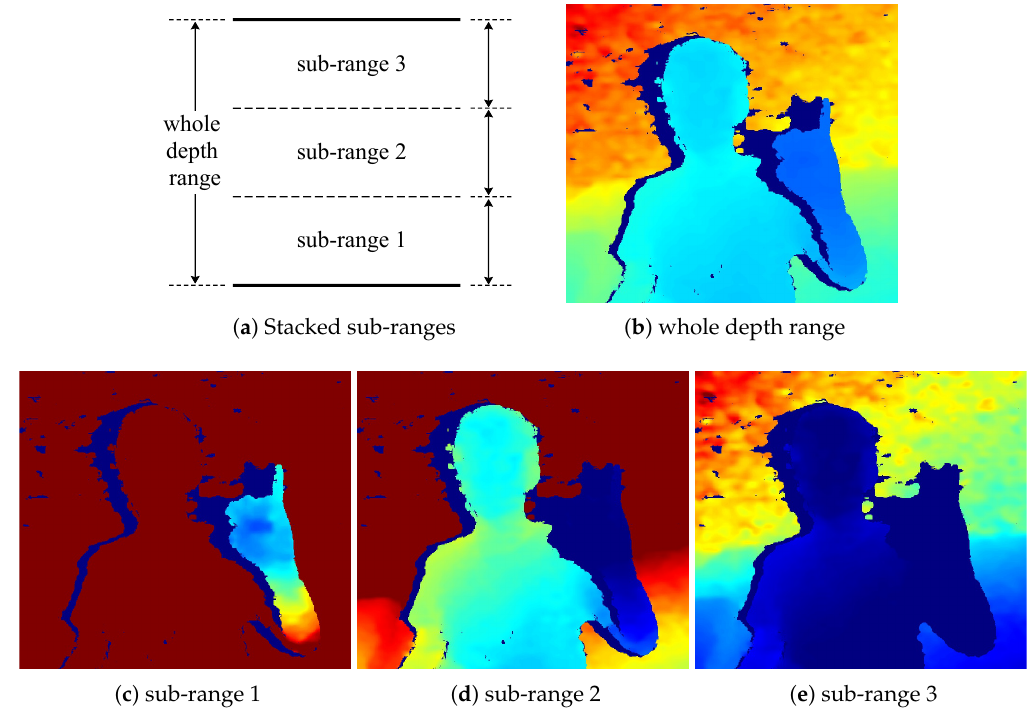
Figure 6. The whole depth range is evenly divided into a series of stacked sub-ranges. In ( b ), the depth image is normalized using the whole depth range. As the hand size is tiny comparing to the whole depth range, the local depth representation on hand is almost “flattened” in the normalized depth image. In ( c ), the depth image is normalized using sub-range 1. Local hand representation (detailed surface information) remains in the normalized depth image of sub-range